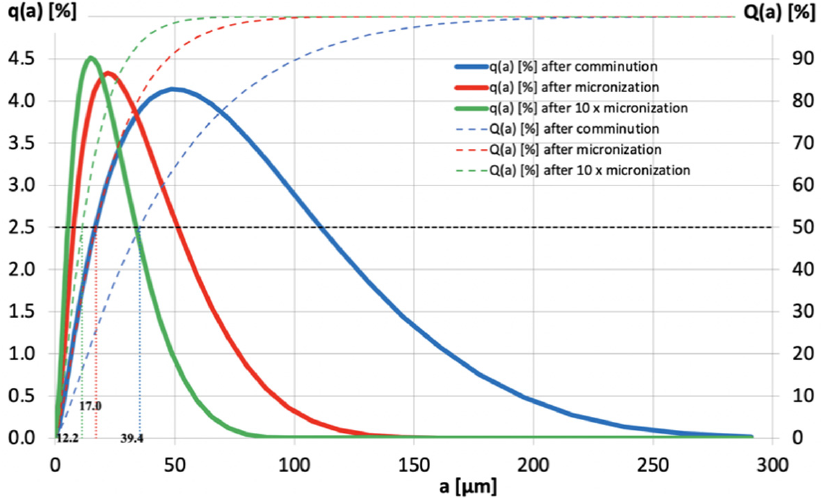
Figure 12. Particle size distributions of hard coal after comminution in a hydro-jet mill and microniza- tion performed in a roto-turbulent micronizer.